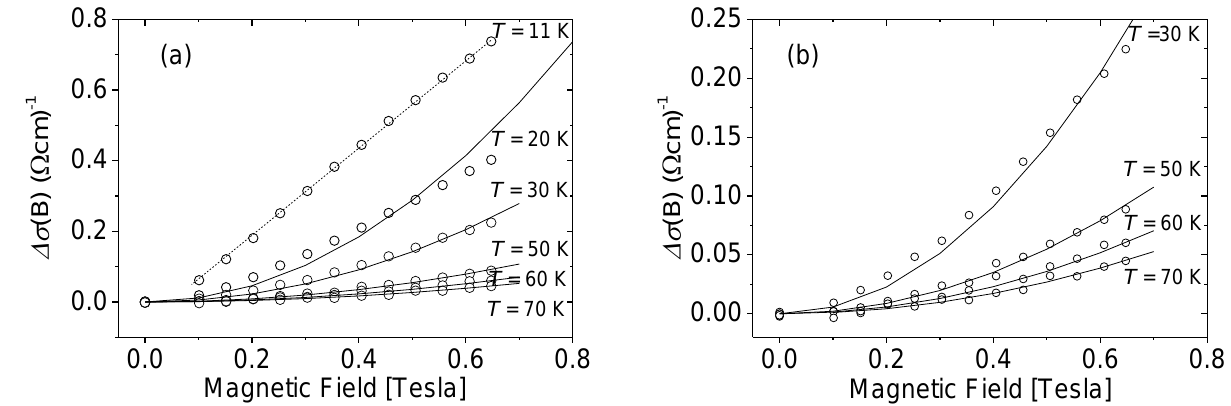
Figure 5. ∆ σ vs. magnetic field B at different temperature. Results for sample M4 with n H = 6.9 × Figure [M11][M2][CM3] 5. [M4] Δ σ vs. magnetic field B at different temperature. Results for